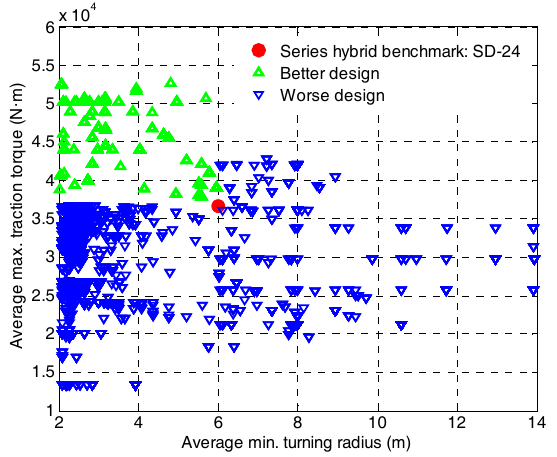
Figure 10. Straight driving and turning performance screening.